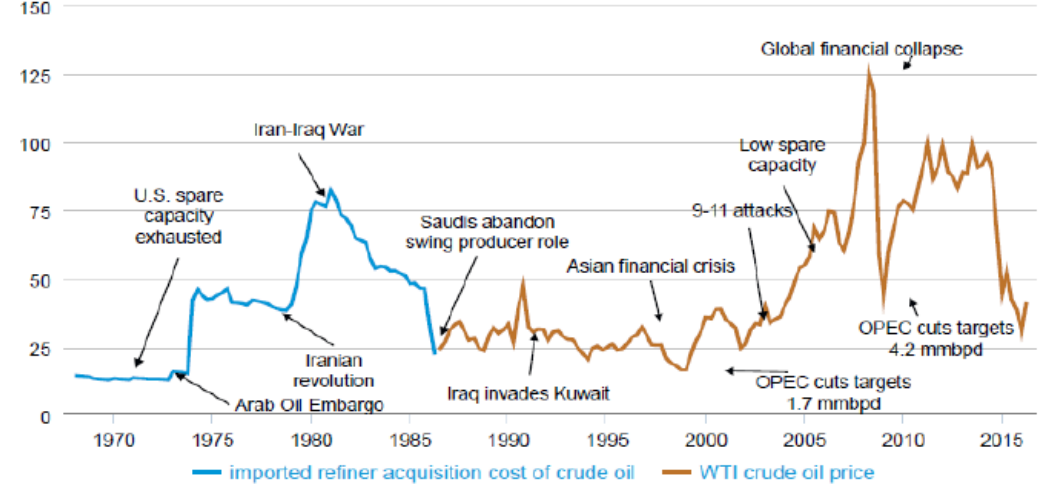
Figure 4. Geopolitical and economic effects on crude price. Source: U.S. Energy Information Administration [2].